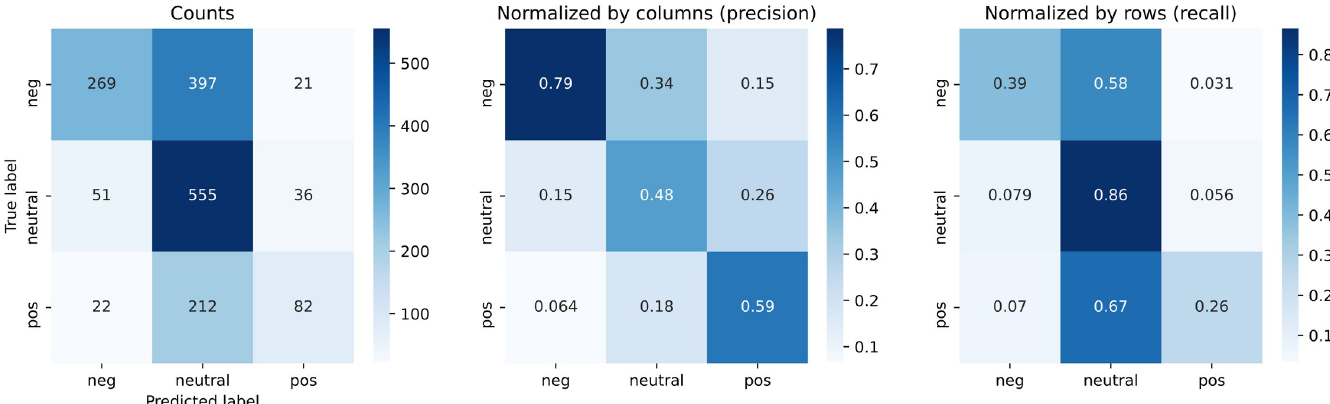
Fig 1. Confusion matrix mention sentiment. The results of the classifier (parameter values: epoch = 25, learning rate = 0.7, n-grams = 3) after applying the simple certainty rule (neutral if certainty < 0.8): confusion matrix with counts (left), normalized by the true labels (middle) and normalized by the predicted labels (right). The values in the diagonals of the middle matrix are the precision rates, and the values on the diagonals of the right matrix are the recall rates. Recall rates here are reduced due to the certainty rule, but the most important errors (classify positive if the true value is negative and classify negative if the true value is positive) are reduced.